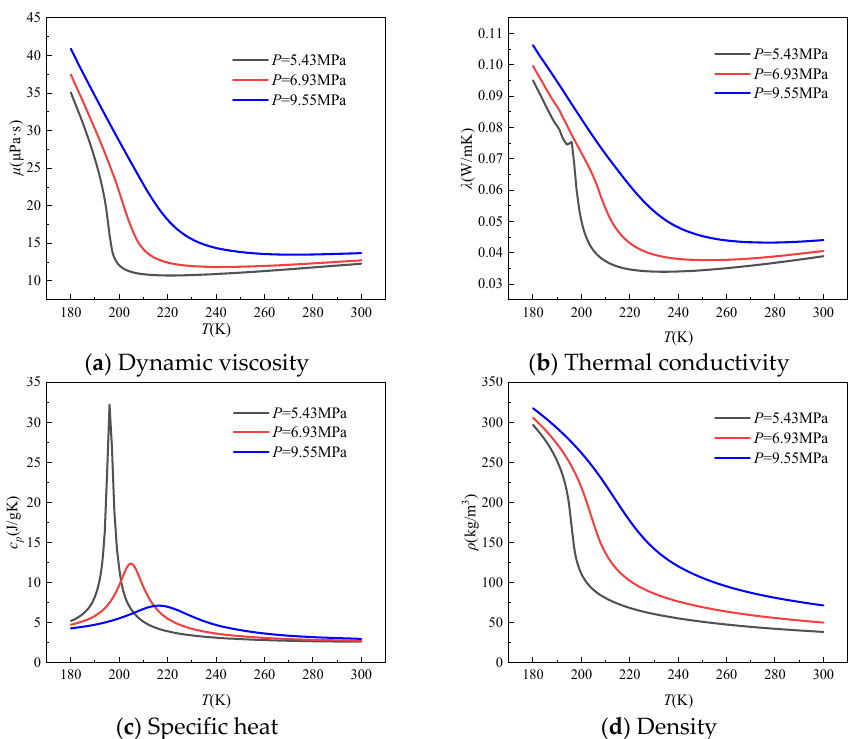
Figure 4. Thermophysical properties of supercritical methane changing with temperature under different pressure conditions.